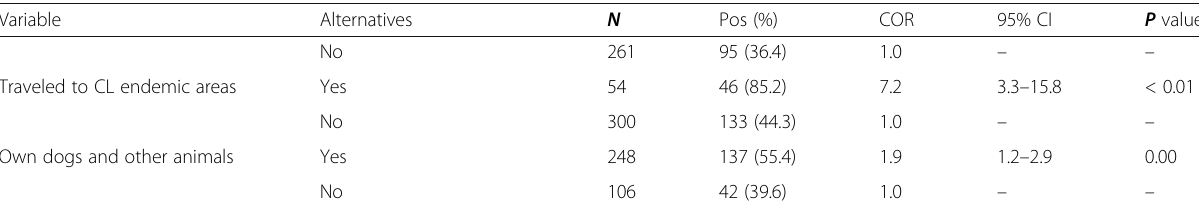
Table 4 Univariable logistic regression analysis of potential determinants in relation to CL positivity at BMH, Dessie town,